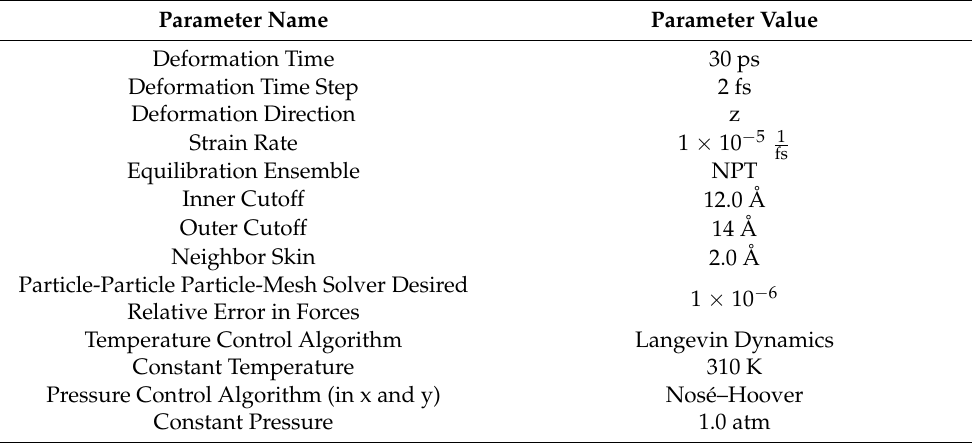
Table 4. Parameters of MD simulation for tensile tests in LAMMPS.